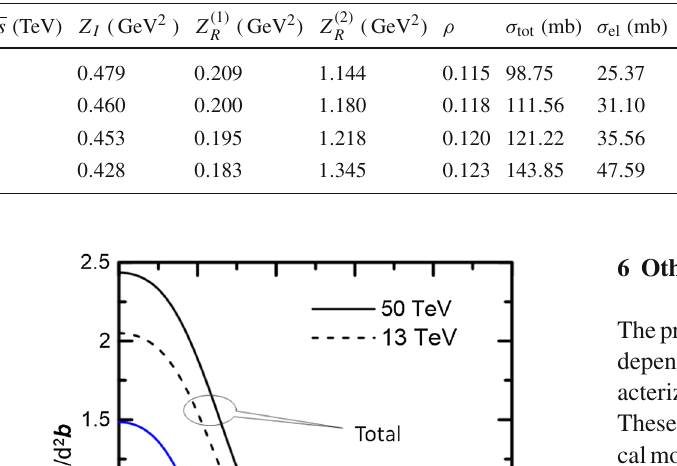
the locations ( | t | values) of the zeros of the imaginary and real ampli- ( 1 ) ( 2 ) tudes, that are important in the dip-bump structure. The integrated cross and Z are R R sections do not show tendency for black disk collision